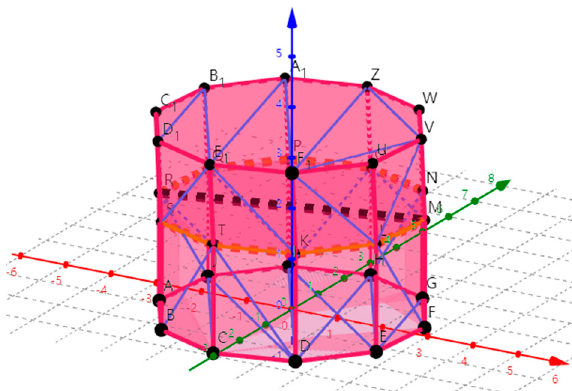
Figure 6. Black dashed line represents the DBH and the orange circle represents the horizontal cross-section ring composed of multiple points at 1.3 m. Red line was the X axis, the green line was the Y axis and the dark blue was the Z axis and the black dots were the vertices of the polygon. Pink line represents the edge of the outermost triangulation network of the polyhedron and the light blue line was the edge of the inner triangulation network of the polyhedron. The color usage of other pictures in this section follows this principle.